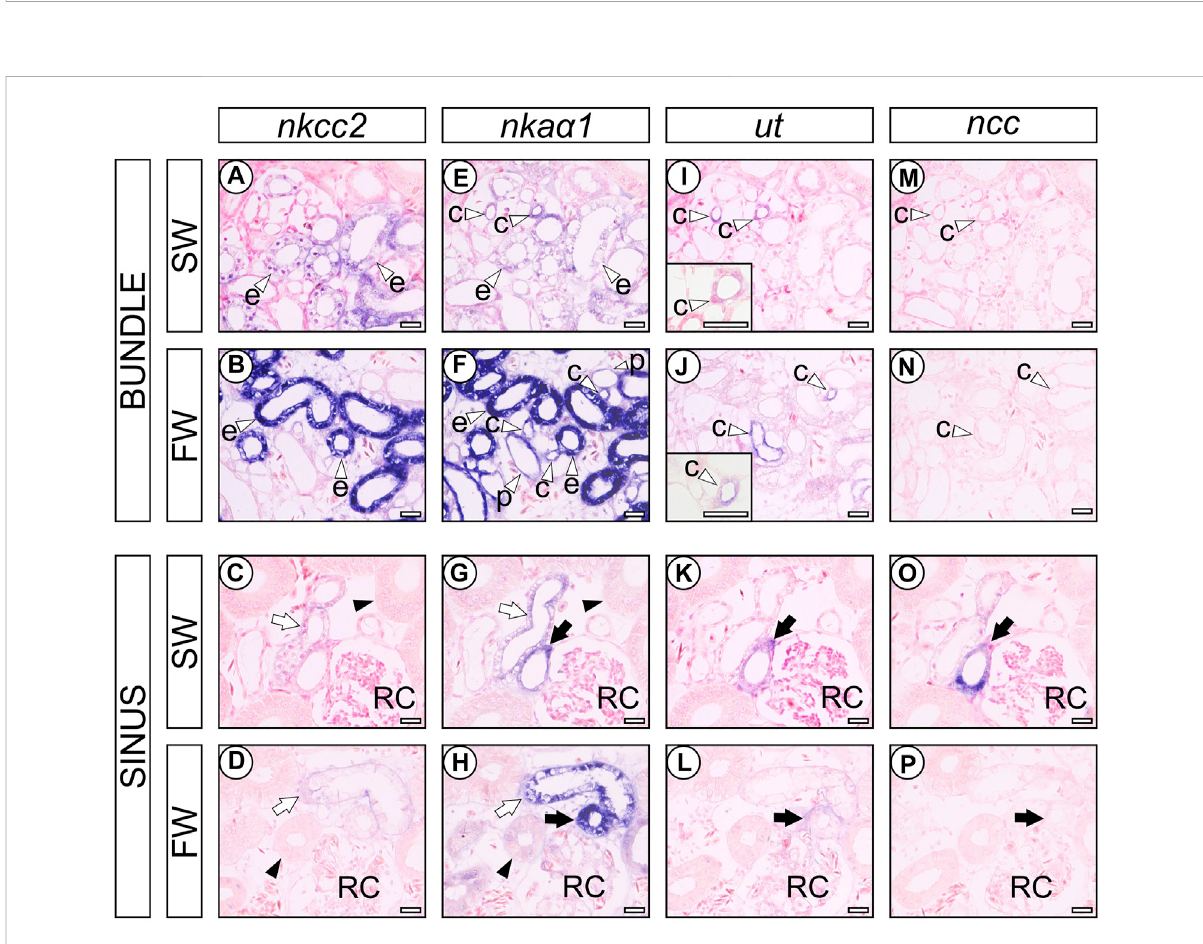
FIGURE 3 In situ hybridization analysis of transporter genes in the nephrons of SW control and FW-acclimated stingrays. nkcc2 (A – D) , nka α 1 (E – H) , ut (I-L) ,and ncc (M-P) inSWcontrol (A,C,E,G,I,K,M,O) andFW-acclimated (B,D,F,H,J,L,N,P) stingray.OpenarrowheadsindicatethePI(labeledwith “ p ” ), EDT (labeled with “ e ” ), and CT (labeled with “ c ” ) in the bundle zone (A,B,E,F,I,J,M,N) . Filled arrowheads indicate the PII (C,D,G,H) . Open and fi lled arrows indicate the ascending and descending LDT, respectively (C,D,G,H,K,L,O,P) . RC, renal corpuscle. Bars, 50 μ m. Note that 1) the nkcc2 mRNA was intensely expressed in the EDT of FW-acclimated stingrays, but no difference was observed in LDT between SW control and FW- acclimated stingrays, and 2) concomitantly, prominent nka α 1 mRNA signals were observed in the EDT of FW-acclimated